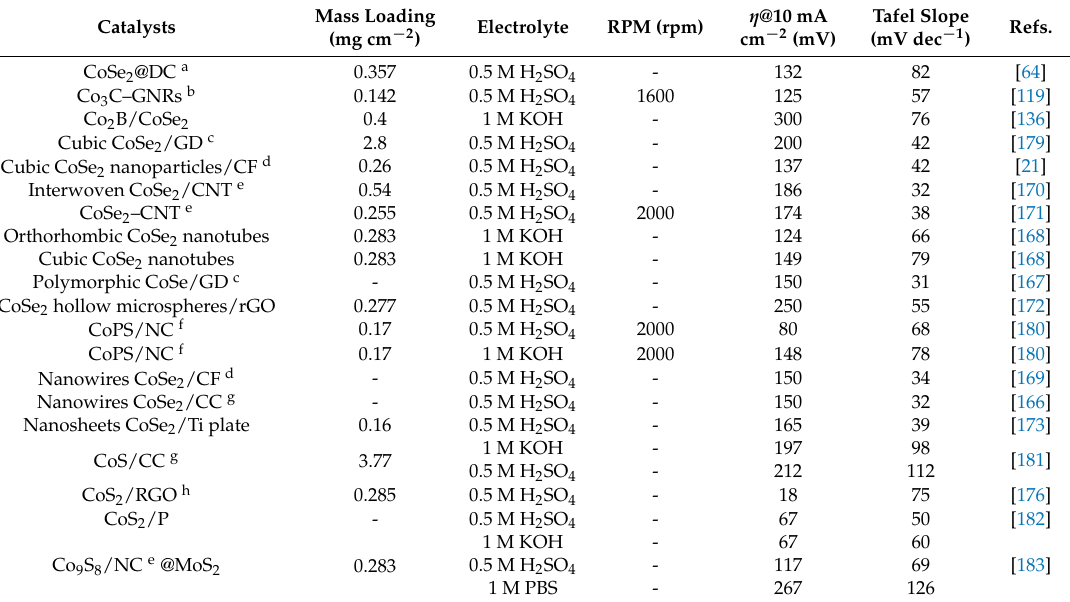
Table 3. Selected state-of-the-art Co-based catalyst towards the hydrogen evolution reaction.